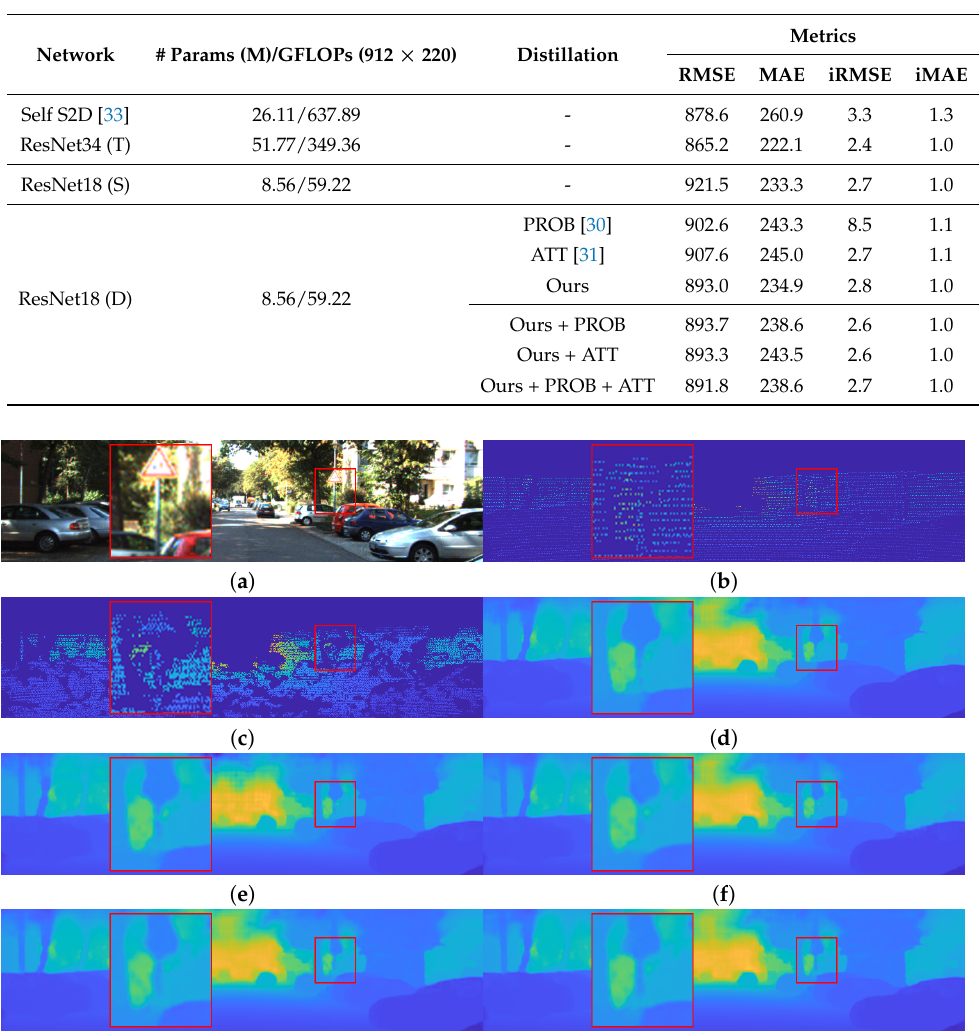
Table 1. Quantitative evaluation results on the KITTI DC validation dataset [32] (T: Teacher, S: Student, D: Distilled).